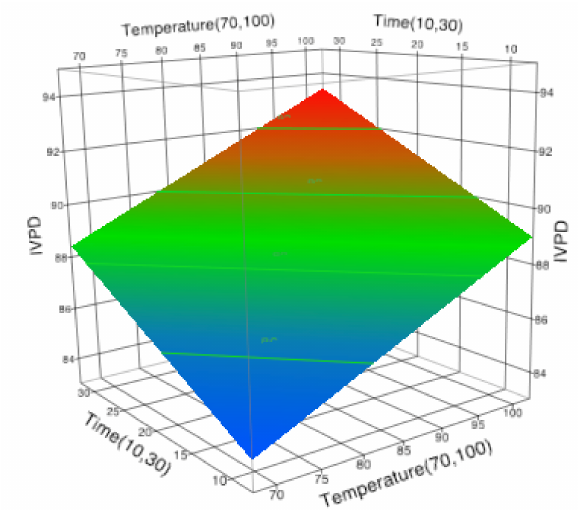
Figure 2. Effect of time (min) and temperature ( ◦ C) on in vitro protein digestibility (IVPD) of soymilk during conventional thermal